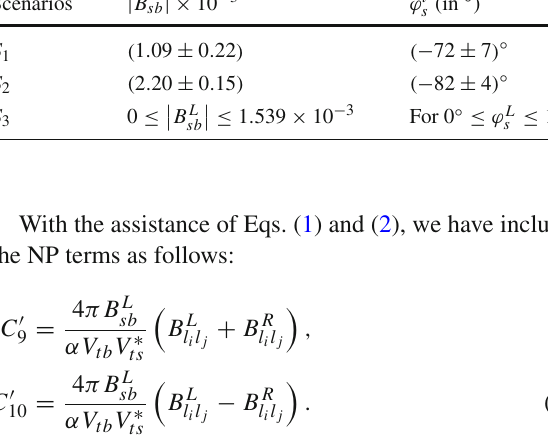
Table 1 Numerical values of coupling parameters